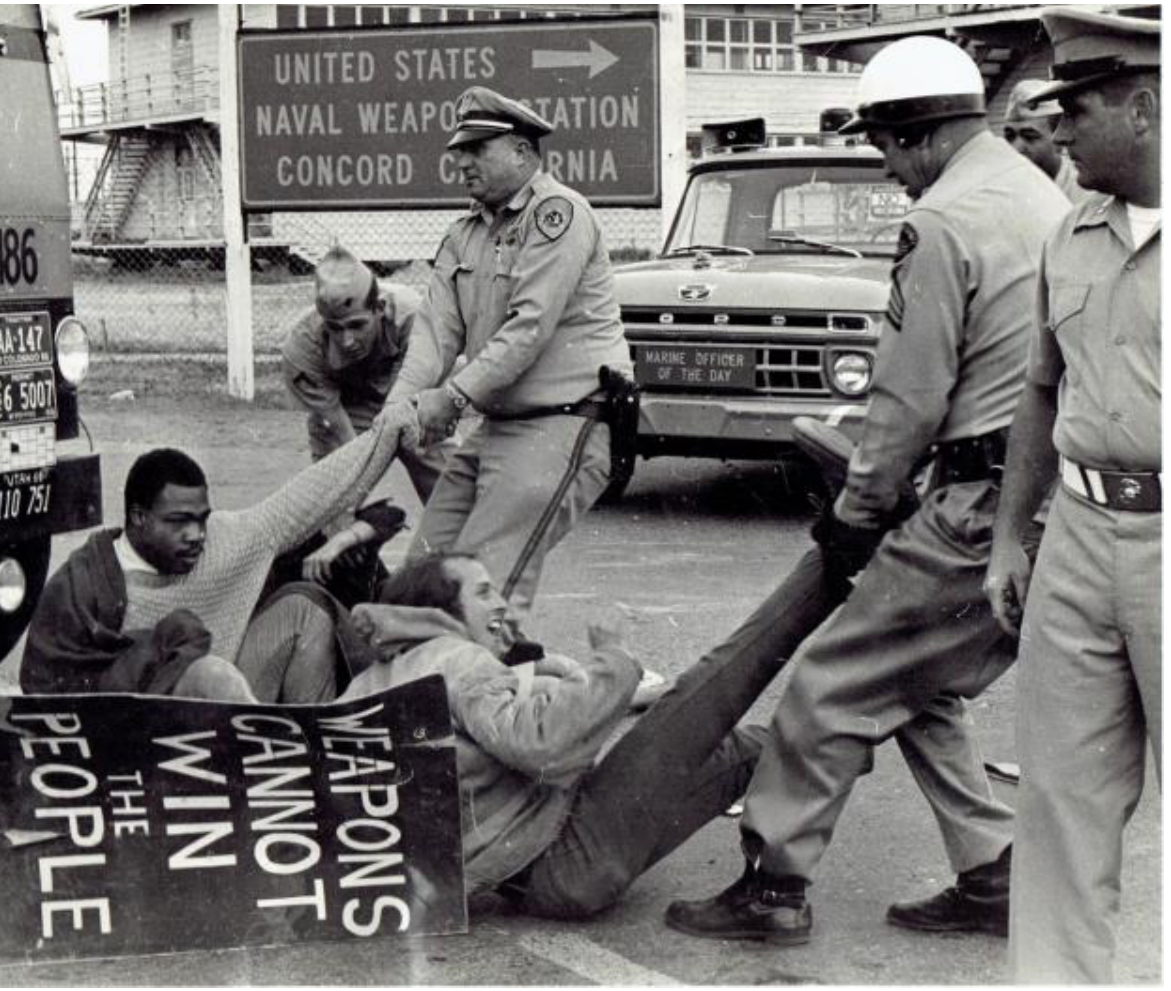
Figure 1. Stopping Napalm Trucks at the Concord Naval Weapons Station. 1967